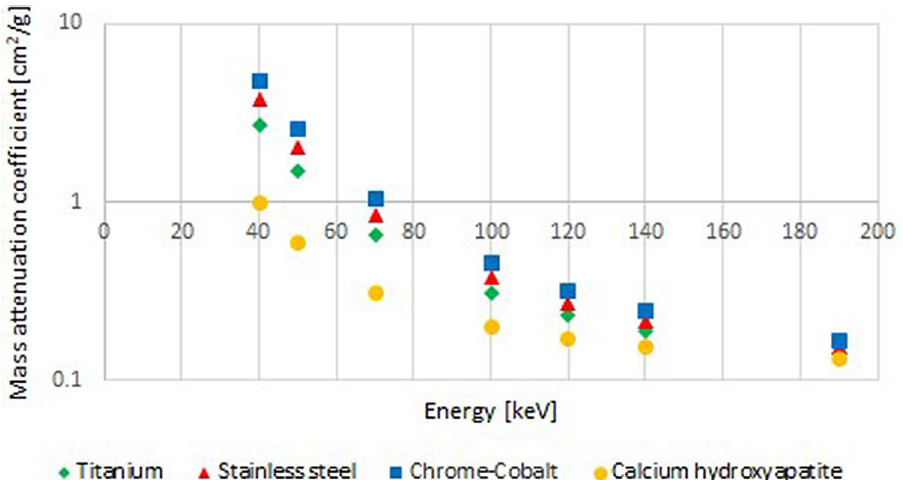
Figure 3. Graph illustrates the linear attenuation coefficient (LAC) in cmy 2 /g of titanium, chrome-cobalt, stainless steel and calcium-hydroxyapatite for different monoenergetic energies in